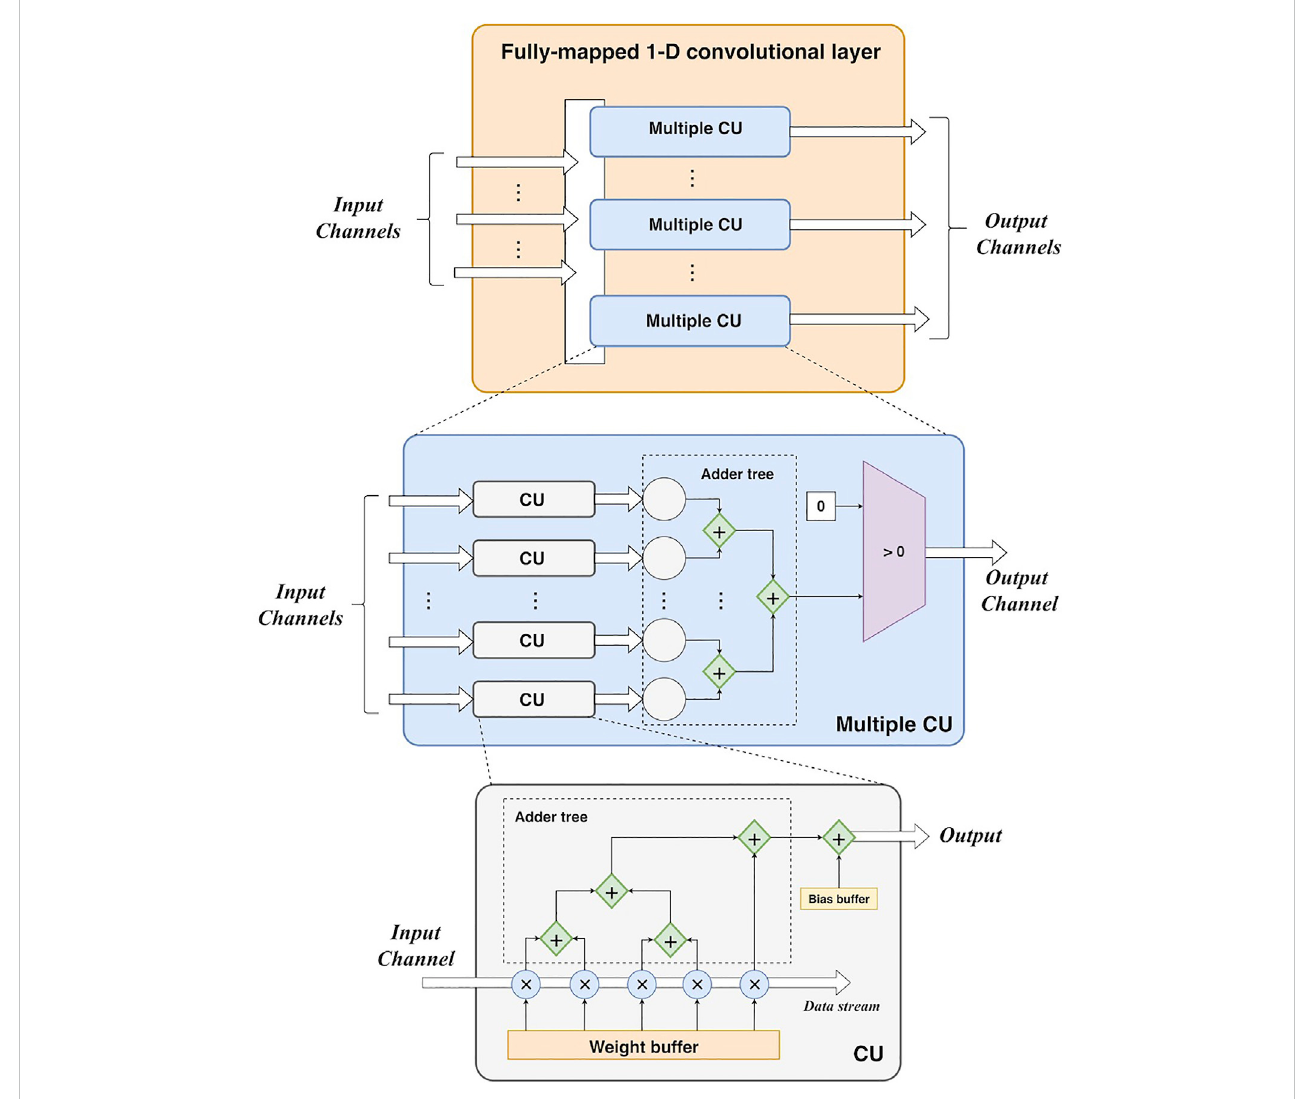
FIGURE 3 The hardware design of a fully-mapped 1-D convolutional layer. CU: convolutional unit.